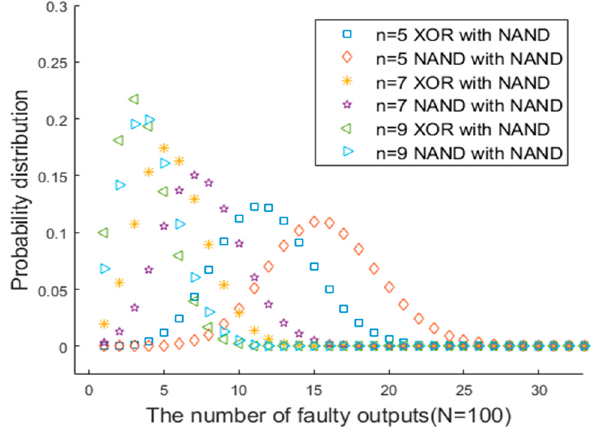
Figure 4. The output error distributions of n stages XOR multiplexing and NAND multiplexing.